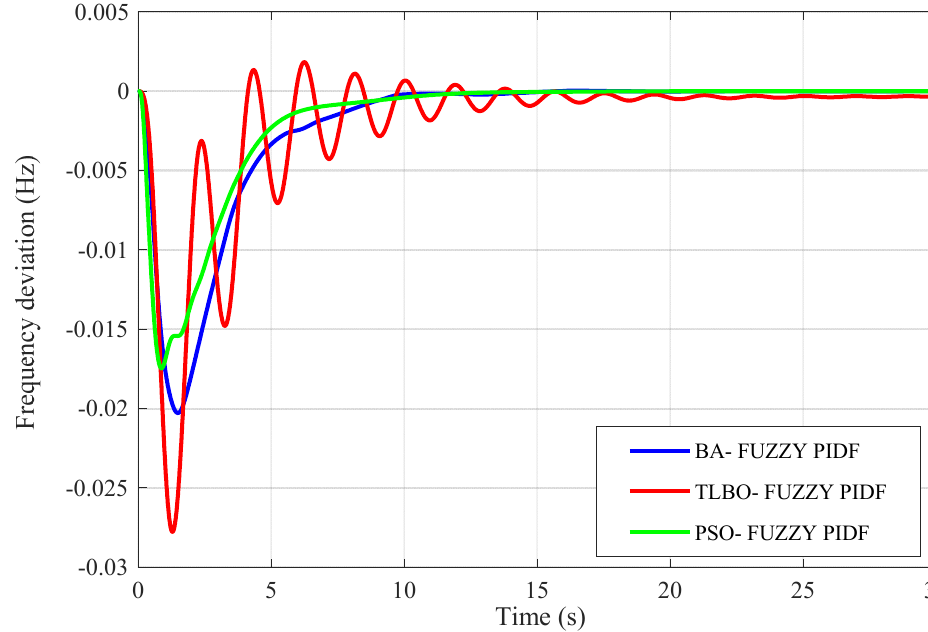
Figure 22. Frequency deviation in area 1 ( ∆ F 2 ) under parametric uncertainties.